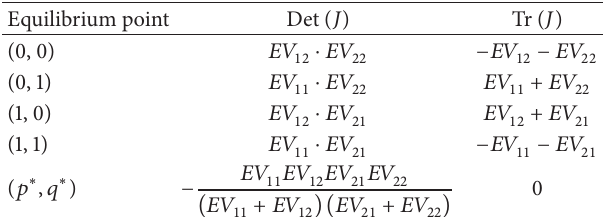
Table 2: Stability